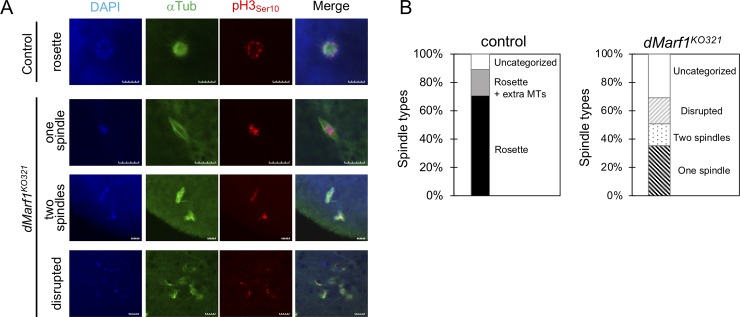
Meiosis I to II transition is compromised in dMarf1KO321 mutant females.(A-B) Meiotic products in the unfertilized egg from the heterozygous control or homozygous dMarf1KO321 females. The microtubule structures were classified into the following categories: control: rosette structure (a fused structure of pronuclei), rosette with two to four extra spindles, and an uncategorized structure; dMarf1KO321: one spindle, two spindles, disrupted spindles/microtubules, and an uncategorized structure. The ratio of each spindle type was plotted in a bar graph (B) (n = 181 for control, and n = 140 for dMarf1KO321), and immunostaining of the corresponding spindle type is shown in (A). DAPI in blue, α-tubulin in green, phospho-histone H3 (an M-phase marker) in red. Scale bar, 10 μm.